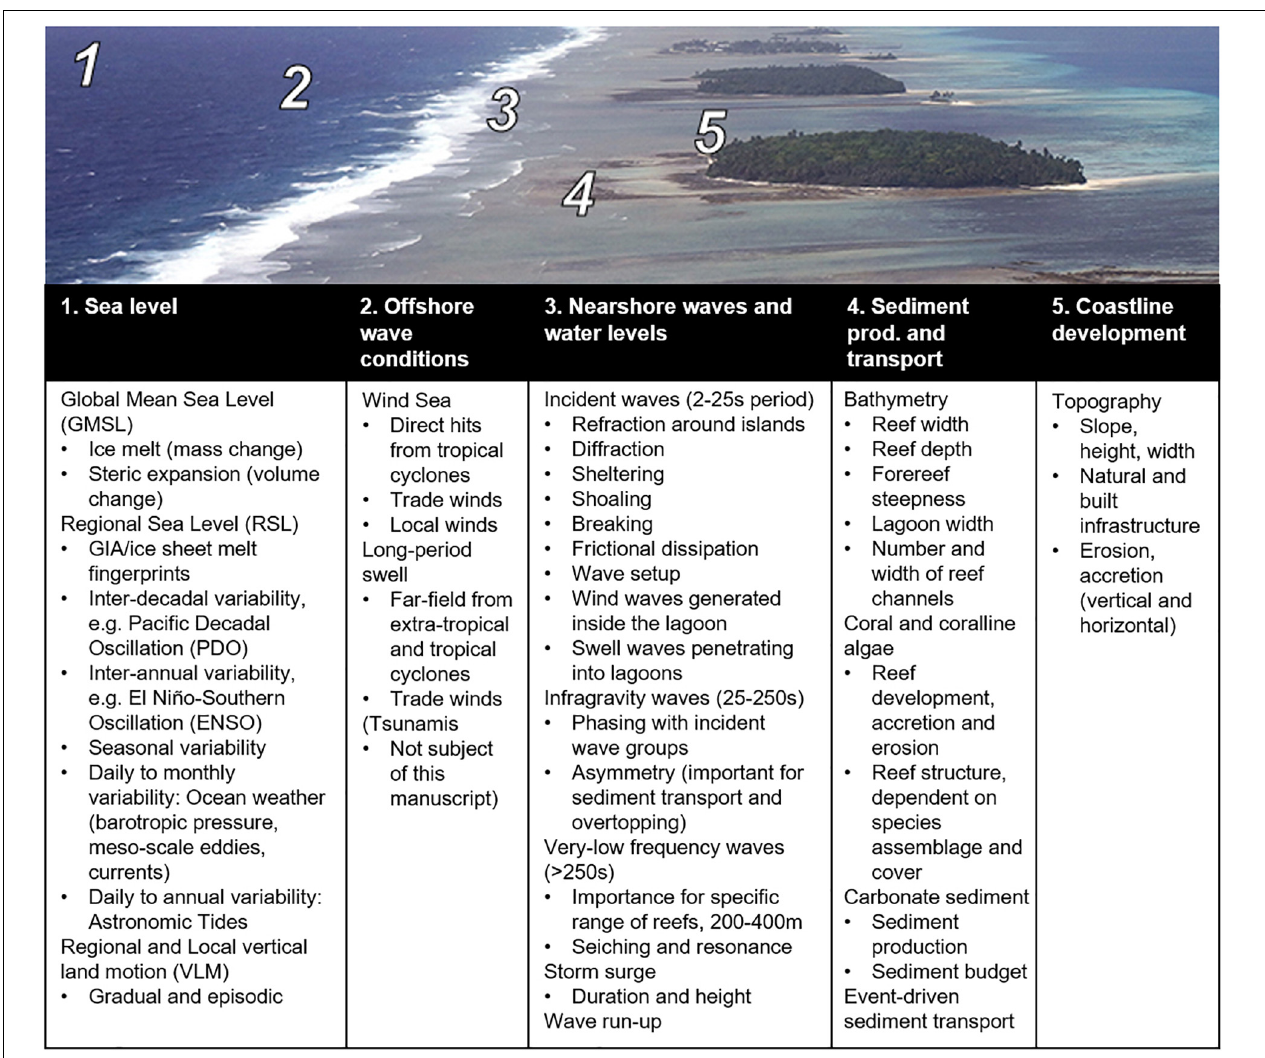
FIGURE 1 | Processes relevant to wave-driven coastal flooding, from offshore to onshore: 1. Sea level. 2. Offshore wave conditions. 3. Nearshore waves and wave-driven water levels. 4. Reef development, sediment production, and reef-to-shore transport. 5. Coastline development. The table lists the key drivers of flooding for each of